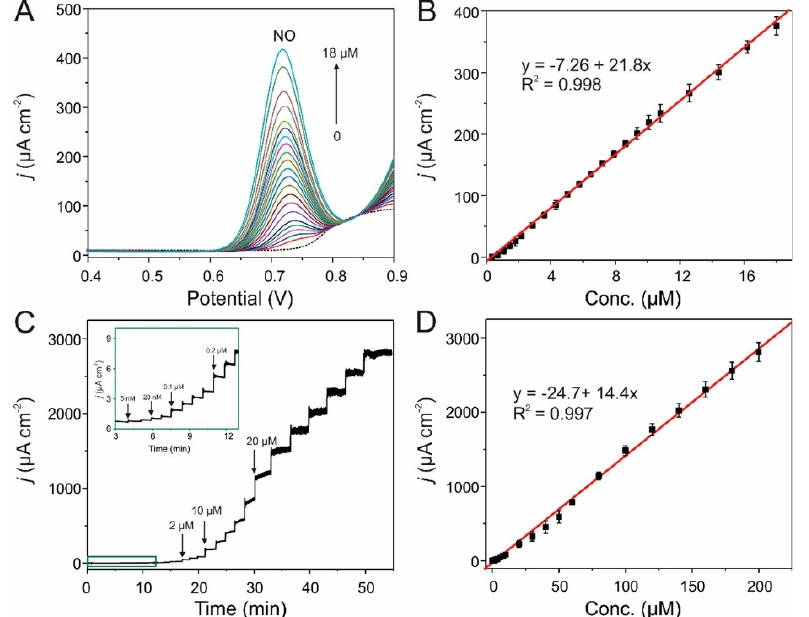
Figure 4. ( A ) DPV responses and ( C ) amperometric responses of the HNG microelectrode for the analysis of different concentrations of NO in 0.1 M of PBS (pH 7.2). The inset in panel ( C ) is the enlarged amperometric responses of NO in the low-concentration range. The applied potential in panel ( C ) was 0.80 V. ( B , D ) The corresponding calibration plots. Each point was expressed as mean ± standard deviation ( n = 3). Reprinted with permission from ref. [64] Copyright 2017, American Chemical Society.